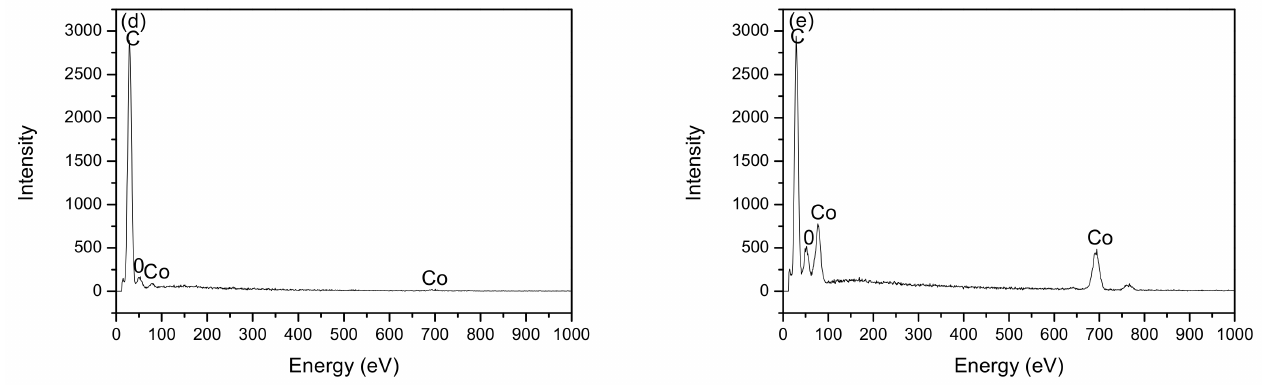
Figure 3. EDX results of ( a ): Co/CNT, ( b ): Co/AC, (c): Co/GO, ( d ): Co/rGO, ( e ): Co/CNF. TEM was utilized to find the morphology of the catalysts and the results are depicted in Figure 4. It can be seen that the small dark black particles of the cobalt metal clusters appeared on the surface of the carbon material. Furthermore, Co 3 O 4 particles are dispersed uniformly on the surface of Co/CNT, Co/AC, and Co/CNF. It can be observed, from the high-resolution TEM results, as shown in Figure 4(a2,c2), that the crystal lattice of Co 3 O 4 (d(3,1,1) = 0.2429 nm) can be clearly spotted. The superior dispersion could lead the desired FT activity, which will be demonstrated with the reaction test results shown in late